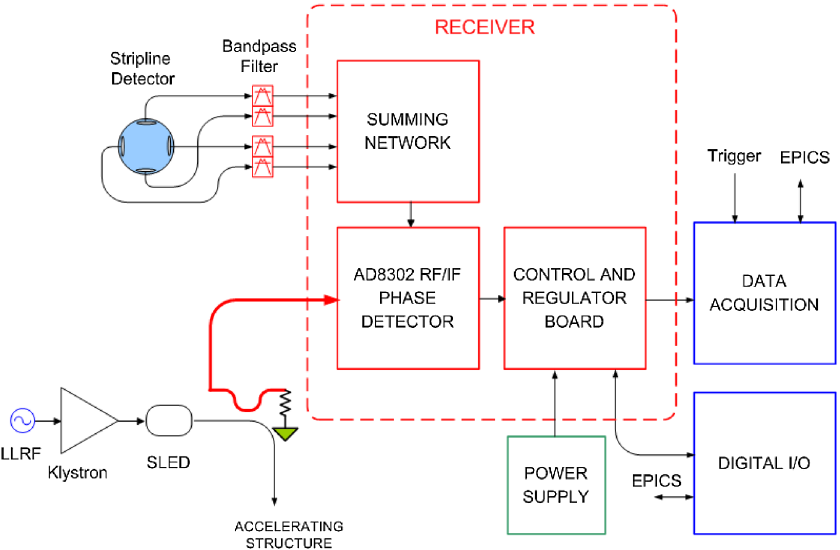
FIG. 3. (Color) Phase detector electronics block